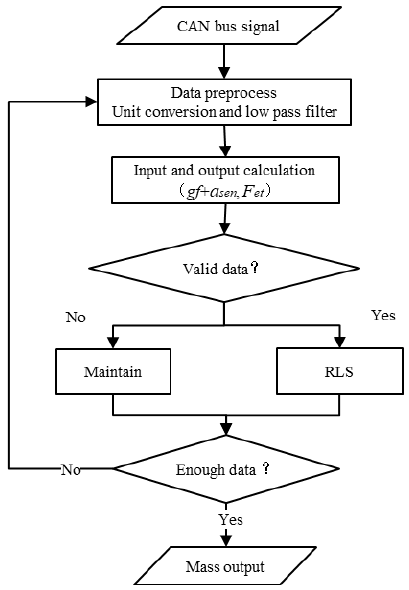
Figure 2. Frame of mass estimation.